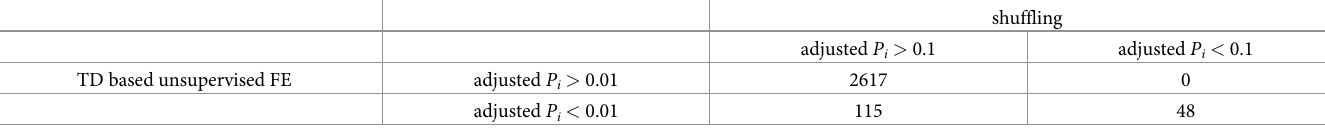
Table 9. Confusion matrix of selected genes between TD-based unsupervised FE and shuffling in the third data set. P -value computed by Fisher’s exact test is 5.00 × 10 − 63